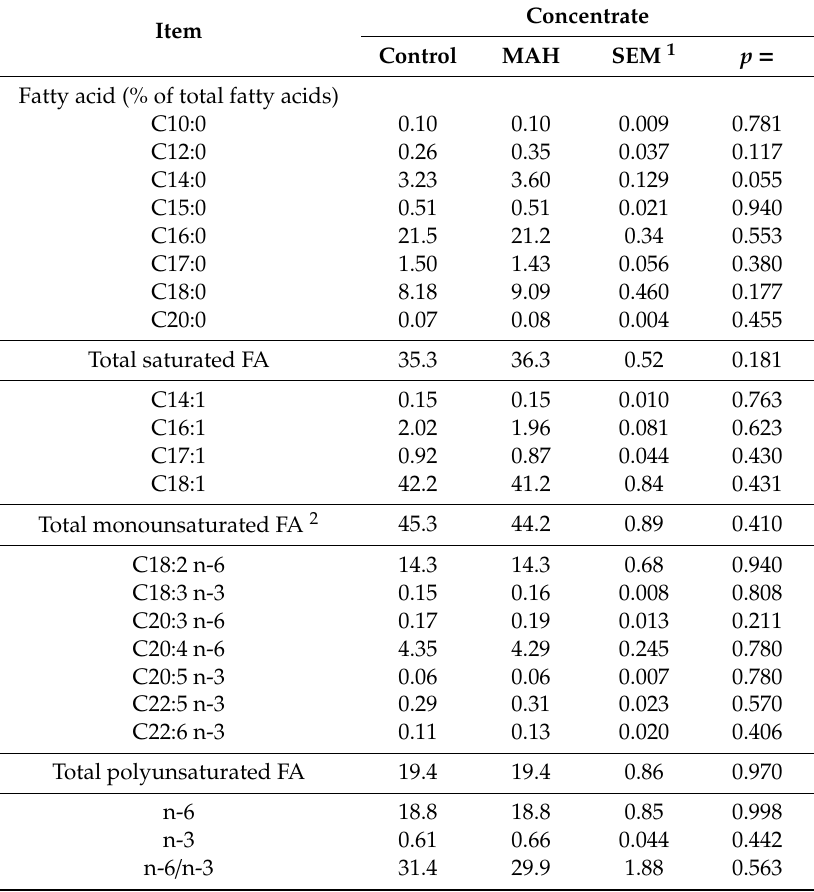
Table 4. Fatty acid (FA) profile of the Longissimus muscle of growing lambs fed barley straw and concentrate containing sunflower meal and seed either untreated (control) or treated with malic acid and heat (MAH). Concentrate Item Control MAH SEM 1 p = Fatty acid (% of total fatty acids)